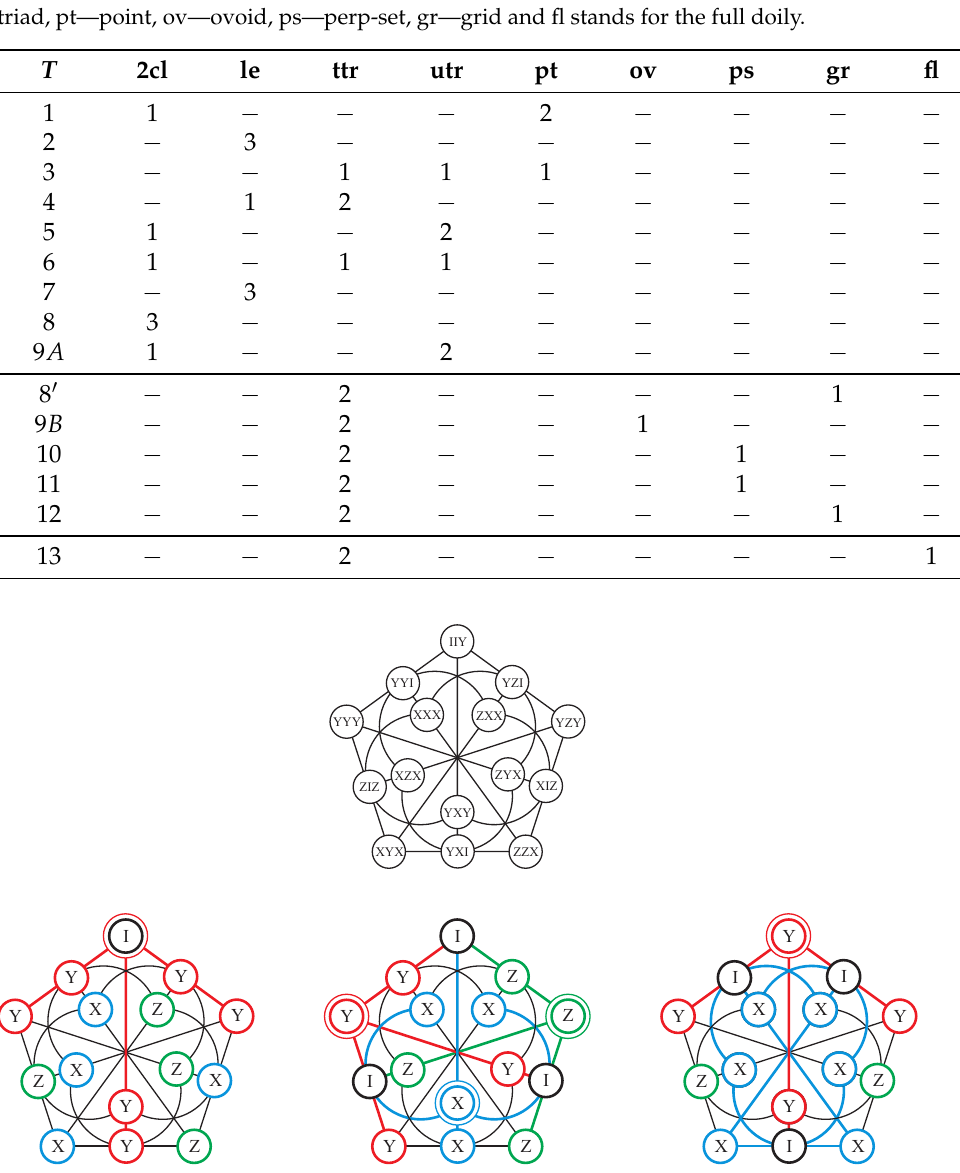
Figure 4. A formal decomposition of a three-qubit doily (top) into three ‘single-qubit residuals’ (bottom). In each doily of the bottom row, the three geometric hyperplanes forming a Veldkamp line are distinguished by different color, with their common points being drawn black; also, the nuclei of perp-sets are represented by double